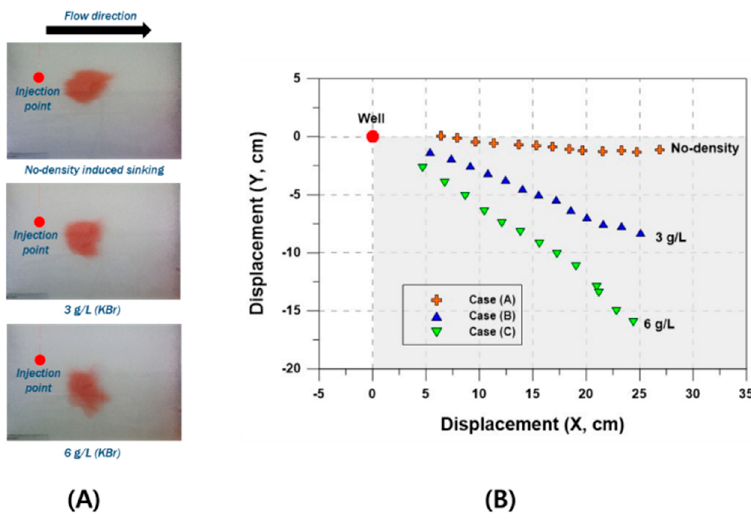
Figure 4. The results of laboratory tests to visualize the movement of tracer with different concentrations (( A ): The position of tracer plume after 30 min, ( B ): Center position of tracer plumes every 5 min analyzed by ImageJ).